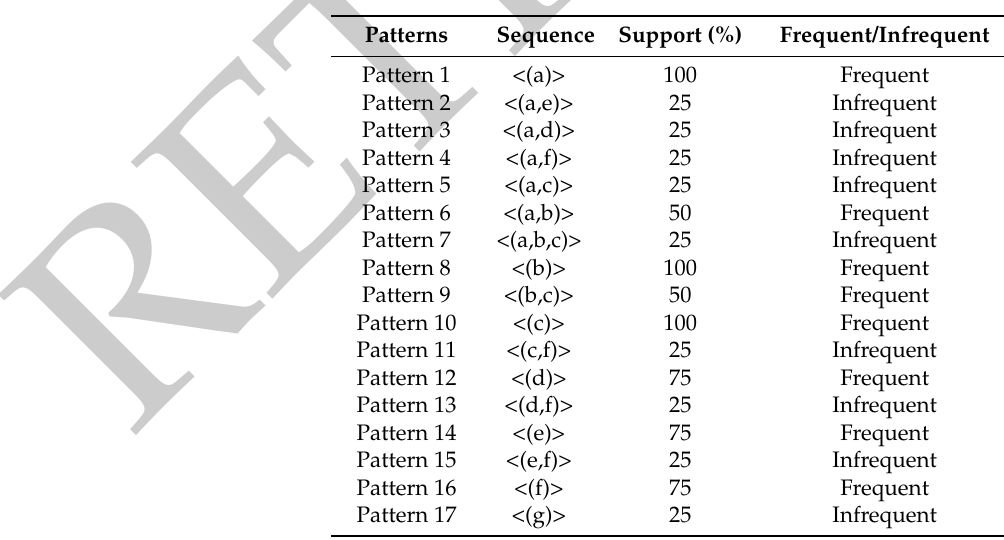
Table 2. The sequential patterns for a